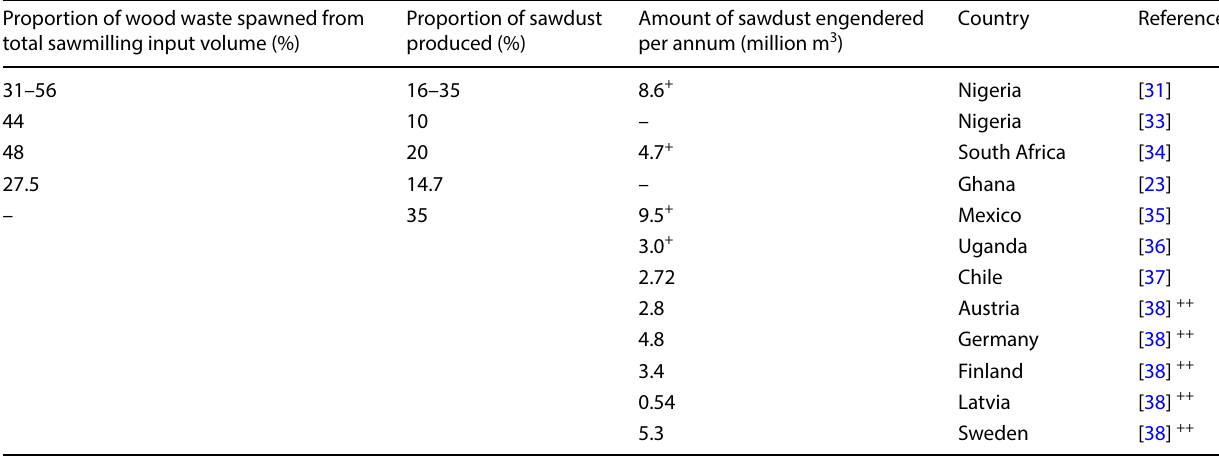
–No obtainable info; + Quantity gaged from volumes using an approximate sawdust density of 210 kg/m 3 , ++ An average from four years saw- dust